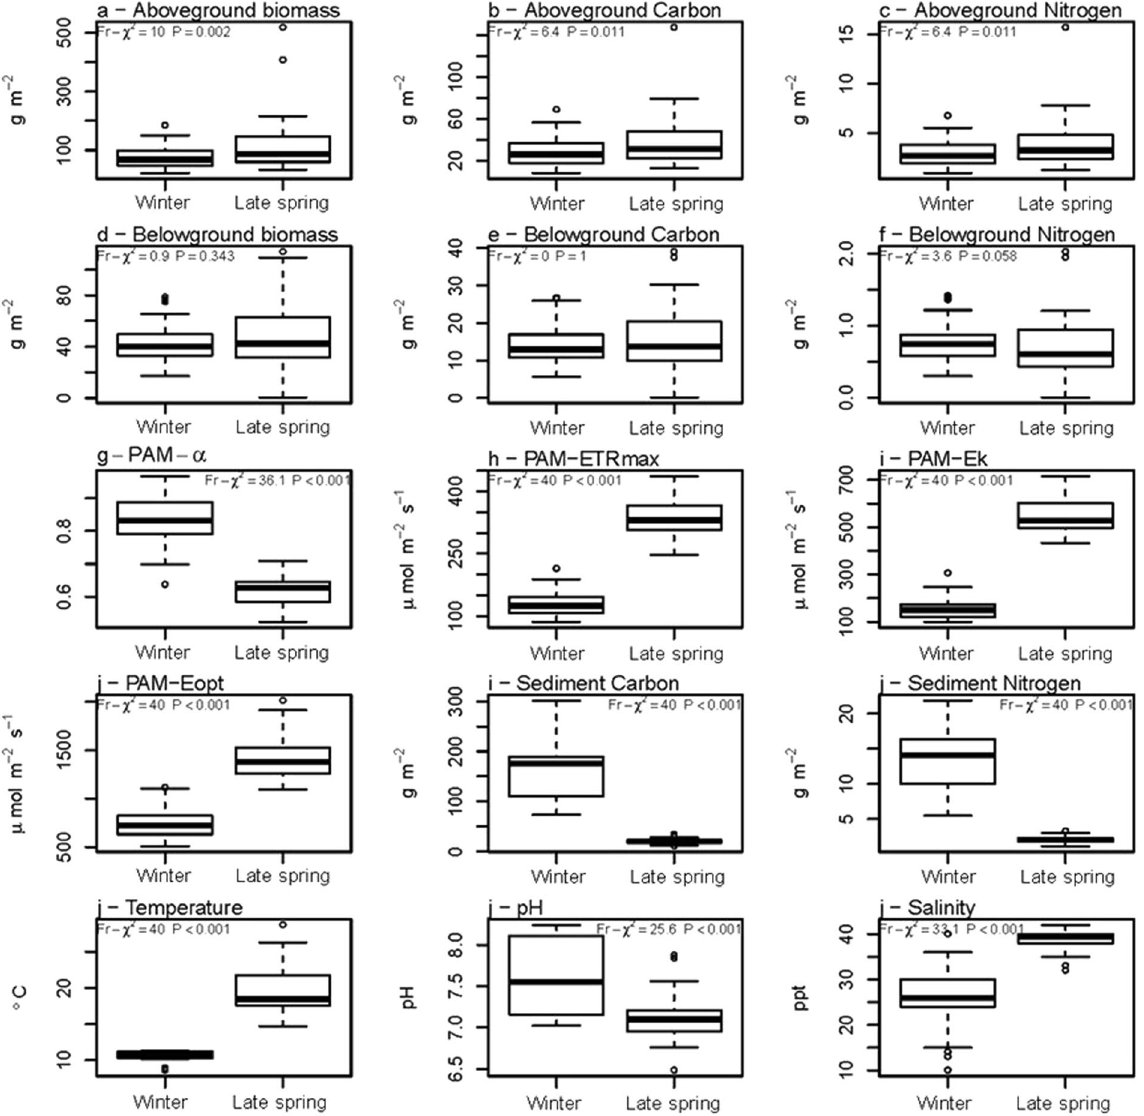
Figure 2. Zostera noltei traits and environmental variables in winter and late spring. Friedman test statistical results are also shown. ( a ): aboveground biomass (gDW m − 2 ), ( b ): aboveground C pool (gC m − 2 ), ( c ): aboveground N pool (gN m − 2 ), ( d ): belowground biomass (gDW m − 2 ), ( e ): belowground C pool (gC m − 2 ), ( f ): belowground N pool (gN m − 2 ); photosynthetic parameters – ( g ): maximum photosynthetic efficiency ( α , μ mol − 1 m 2 s 1 ), ( h ): maximum relative electron transport rate (rETR), ( i ): photoacclimation index (E m − 2 s − 1 ), ( j ): optimum irradiance (E opt , μ mol m − 2 s − 1 ); environmental parameters – ( j ): sediment C pool (gC m − 2 cm − 1 ), ( k ): sediment N pool (gC m − 2 cm − 1 ), sediment temperature (°C), sediment pH, sediment (interstitial water